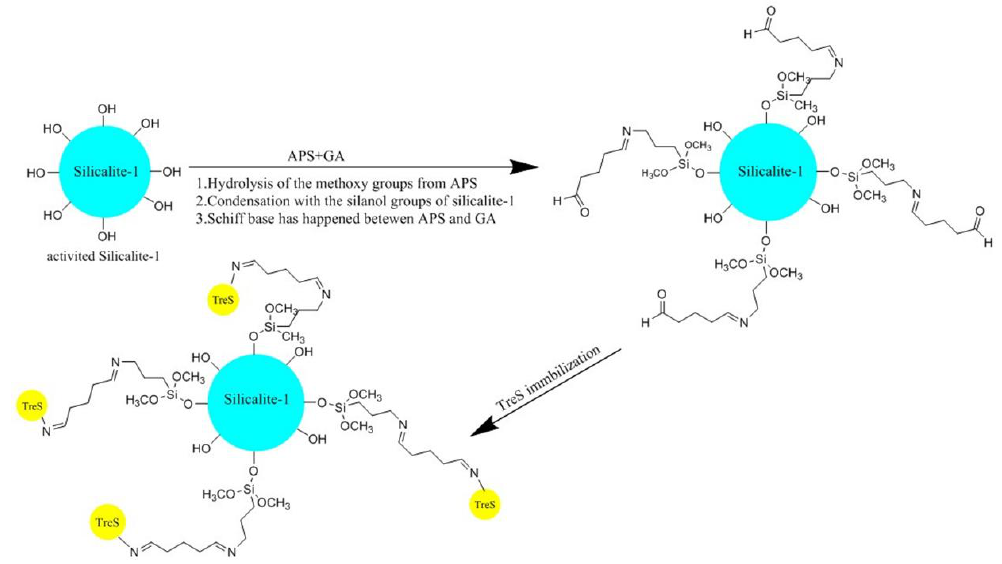
Figure 1. Immobilization process of TtTreS (trehalose synthase (Tres) derived from Thermus thermophilus HB27) on silicalite-1-based material.